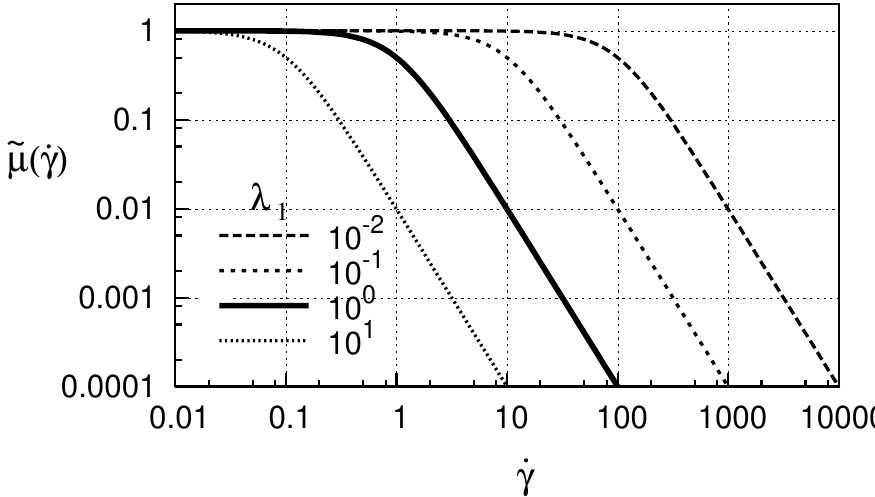
Figure 6. Viscosity dependence on shear-rate ˙ γ and parameter λ 1 (fixed a =